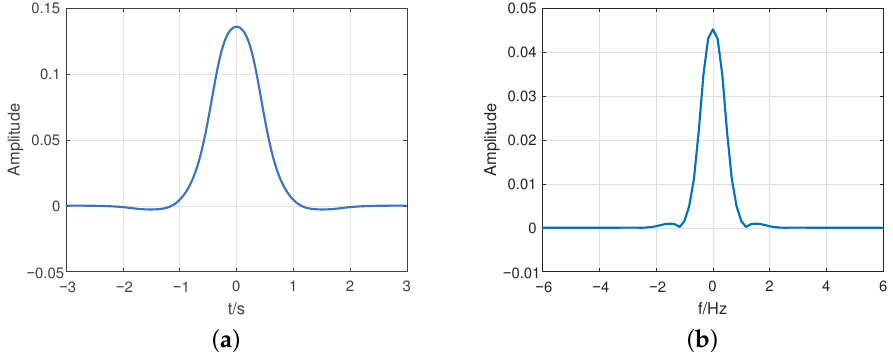
Figure 9. IOTA filter in time and frequency domain. ( a ) Time domain. ( b ) Frequency